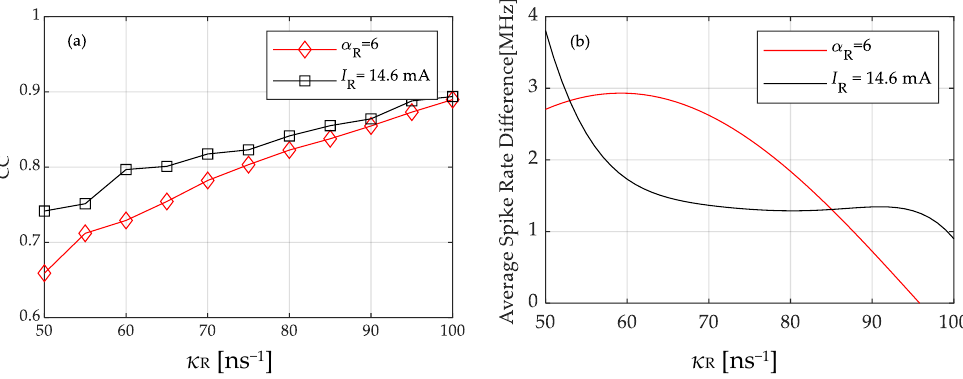
Figure 10. Effect of injection strength on the LFF transmission performance. The pump current and linewidth enhancement factor are 15 mA and 5, respectively. ( a ) Correlation coefficient, ( b ) average spike rate difference.